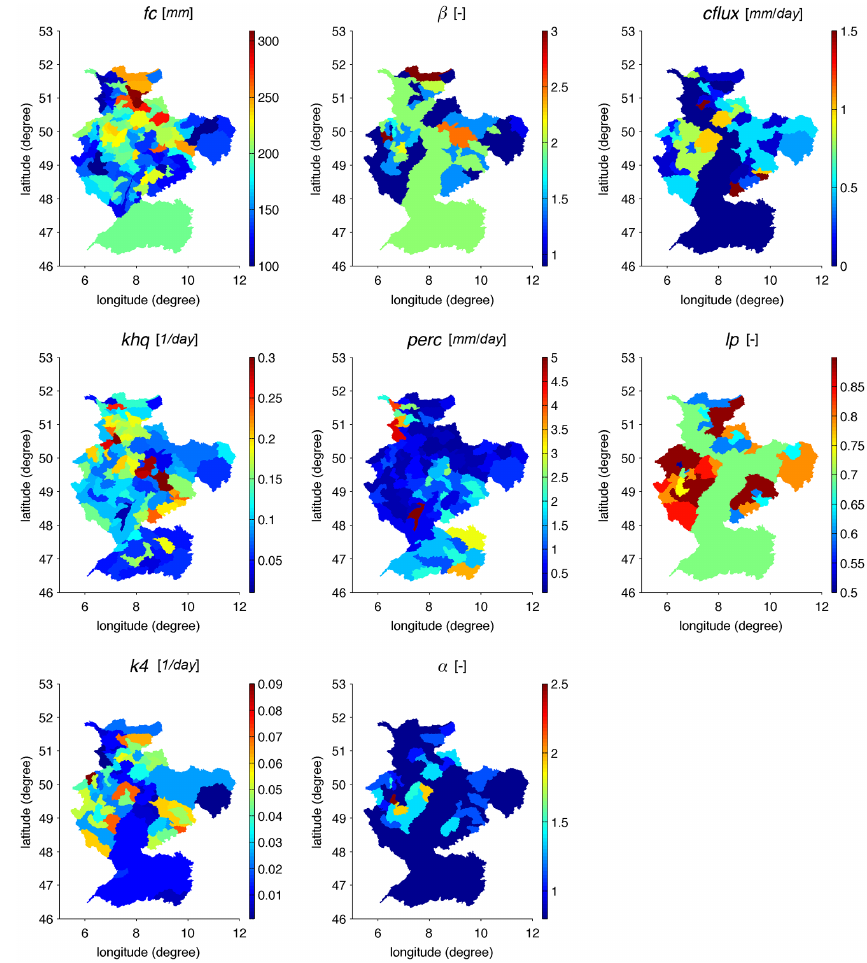
Figure 3. Calibrated parameters of the soil moisture and runoff response routines of the OpenStreams wflow_hbv model.